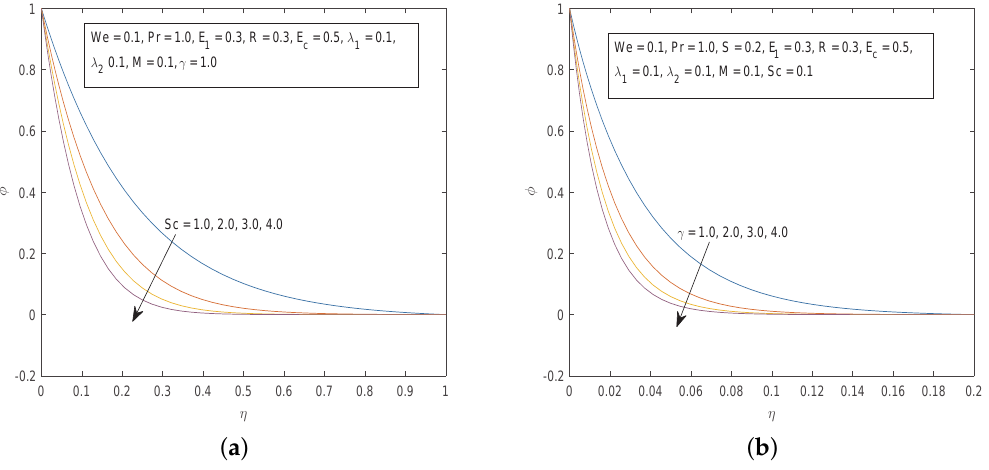
Figure 5. ( a ) Effects of Sc on φ and ( b ) Effects of γ on φ .